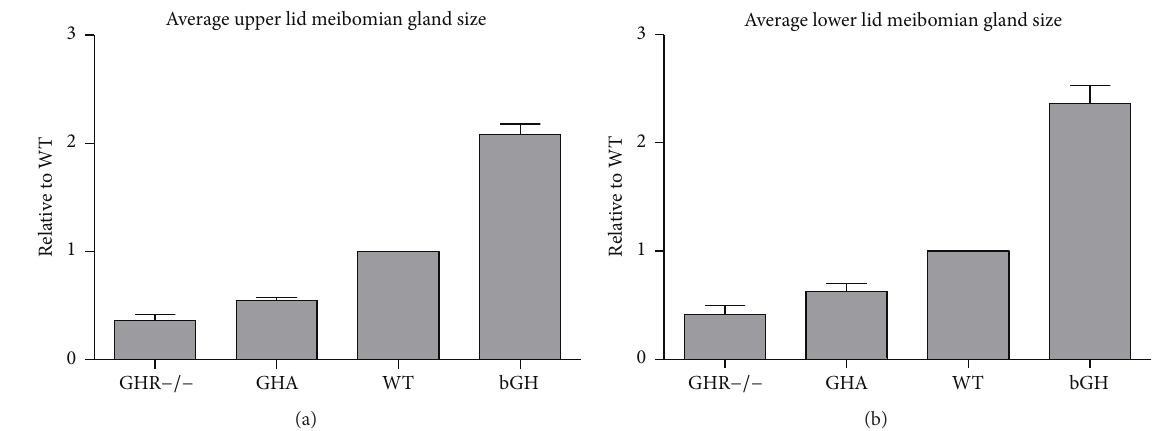
Figure 5: The ratio of average meibomian gland size relative to WT controls in GHR − / − , GHA, and bGH mice for both upper (a) and lower (b) eyelids. The WT in each group was set to 1. For the GHA group, the data for both sexes were pooled. Data shown are mean ratios ± SEM.